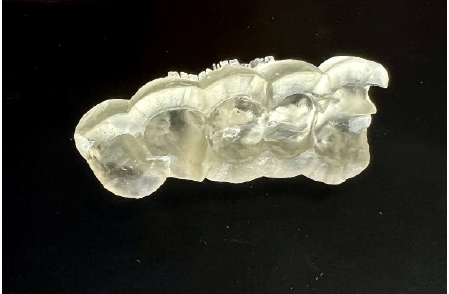
Int. J. Environ. Res. Public Health 2022 , 19 , x FOR PEER REVIEW Figure 13. Three-dimensional printed endodontic guide. Figure 13. Three-dimensional printed endodontic guide. Figure 13. Three-dimensional printed endodontic guide.